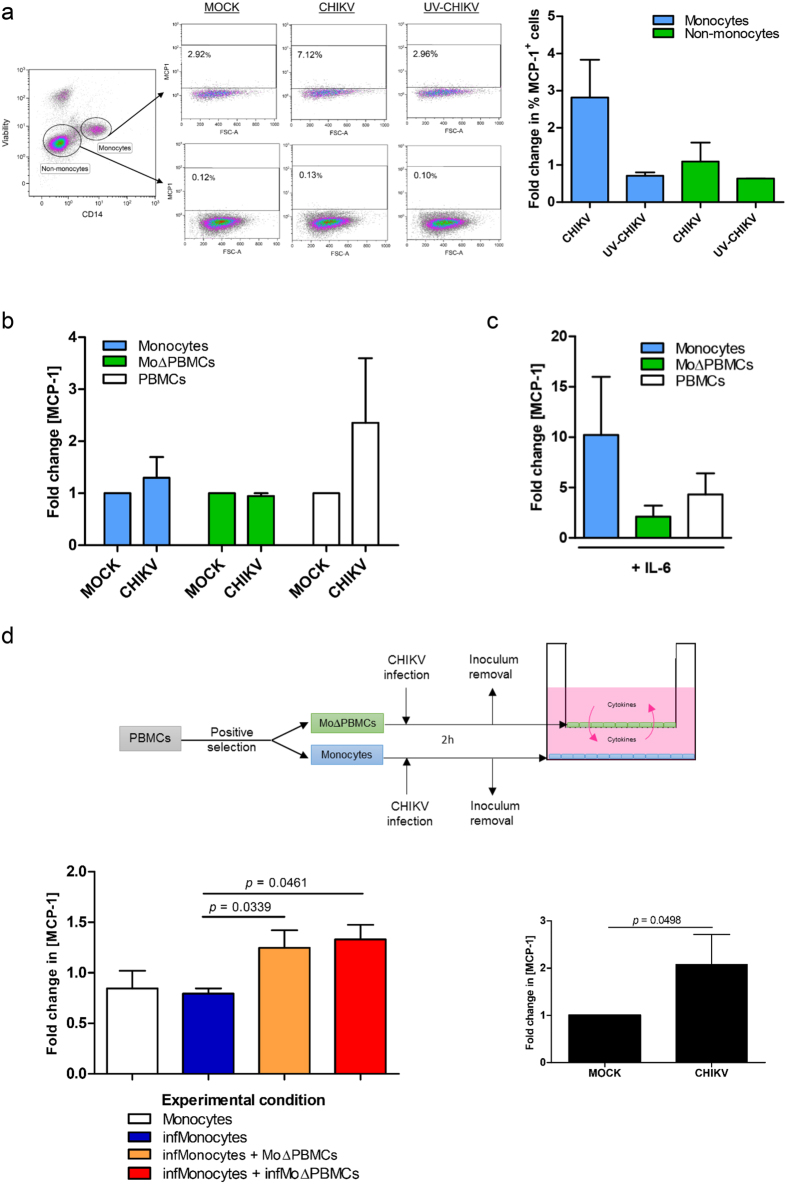
Monocytes are the primary source of MCP-1 among PBMCs in response to CHIKV infection however they require other cells to be able to produce it.(a) CHIKV-induced MCP-1 expression was found primarily in monocytes (defined as CD14+ cells). Bars represent mean + s.e.m., n = 3. (b) Infection of monocyte-depleted PBMCs (Mo∆PBMCs) or monocytes did not result in MCP-1 production 24 hpi. Infection of PBMCs from the same donors stimulated MCP-1 secretion. Bars represent mean + s.e.m., n = 3. (c) Monocytes, Mo∆PBMCs and PBMCs produced MCP-1 in response to IL-6 stimulation. Bars show mean fold increase over non-stimulated cells + s.e.m., n ≥ 3. (d) Transwell co-culture of Mo∆PBMCs with infected monocytes (infMonocytes) restored the capacity of the latter to secrete MCP-1. The right panel shows MCP-1 production of PBMCs from the same donors used in the transwell co-culture experiments. Bars represent mean fold increase over mock-infected (Monocytes + Mo∆PBMCs) + s.e.m., n = 3.